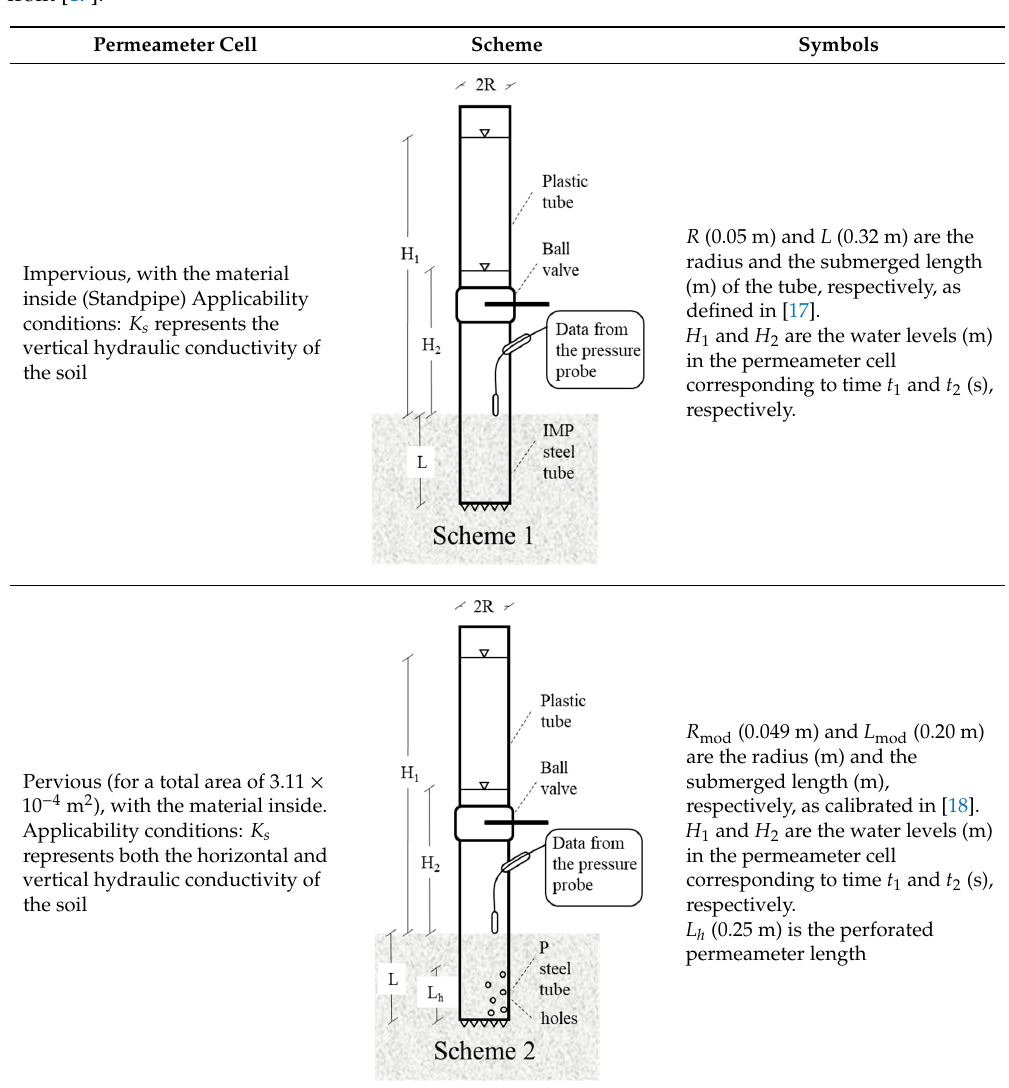
Table 1. Schemes and equations tested for the K s measurements by the falling-head method, adapted from [17].